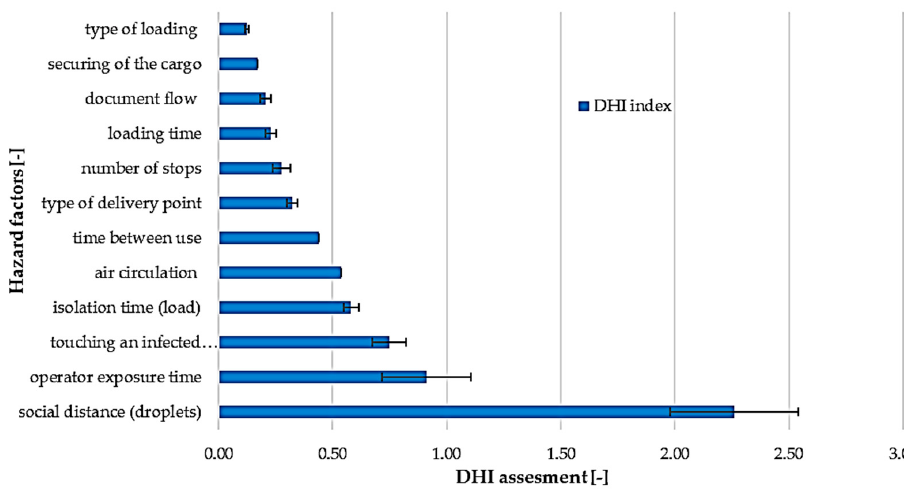
Figure 7. Comparison of total hazard assessment and DHI indexes.